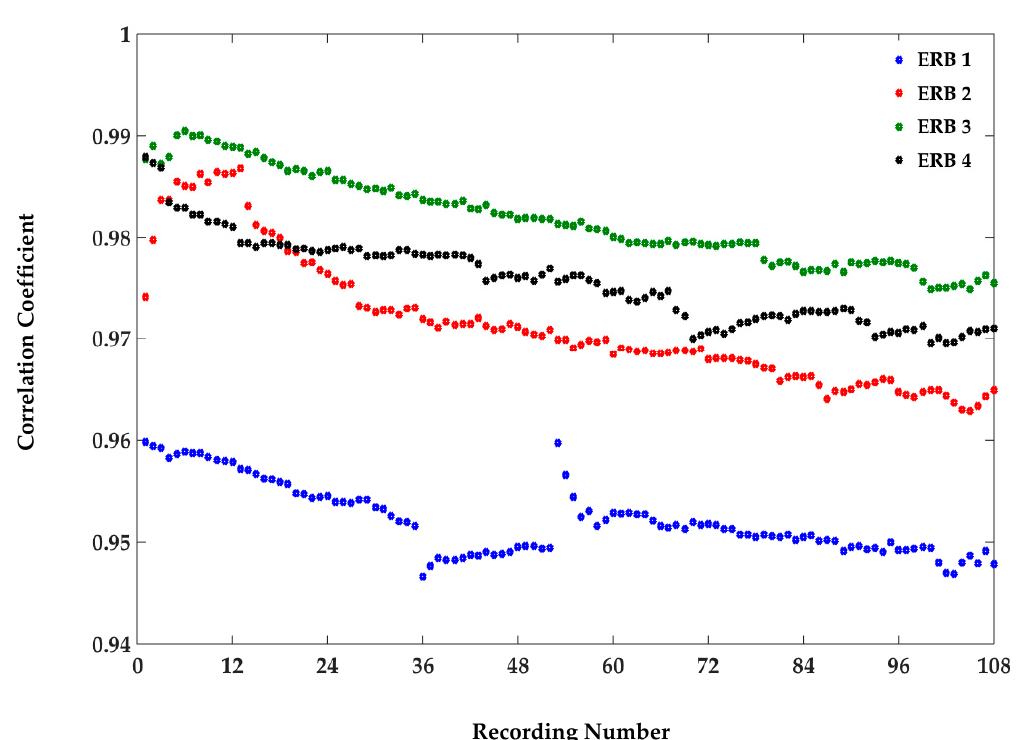
Figure 7. Correlation coefficient of the ERB and the SP sensor for 108 recordings. Different colors refer to different band used in the experiment.